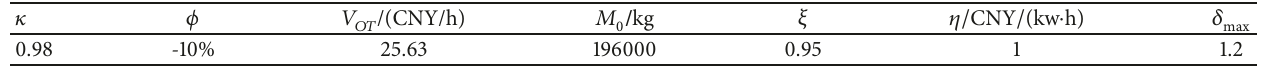
Table 3: Other parameters used in the